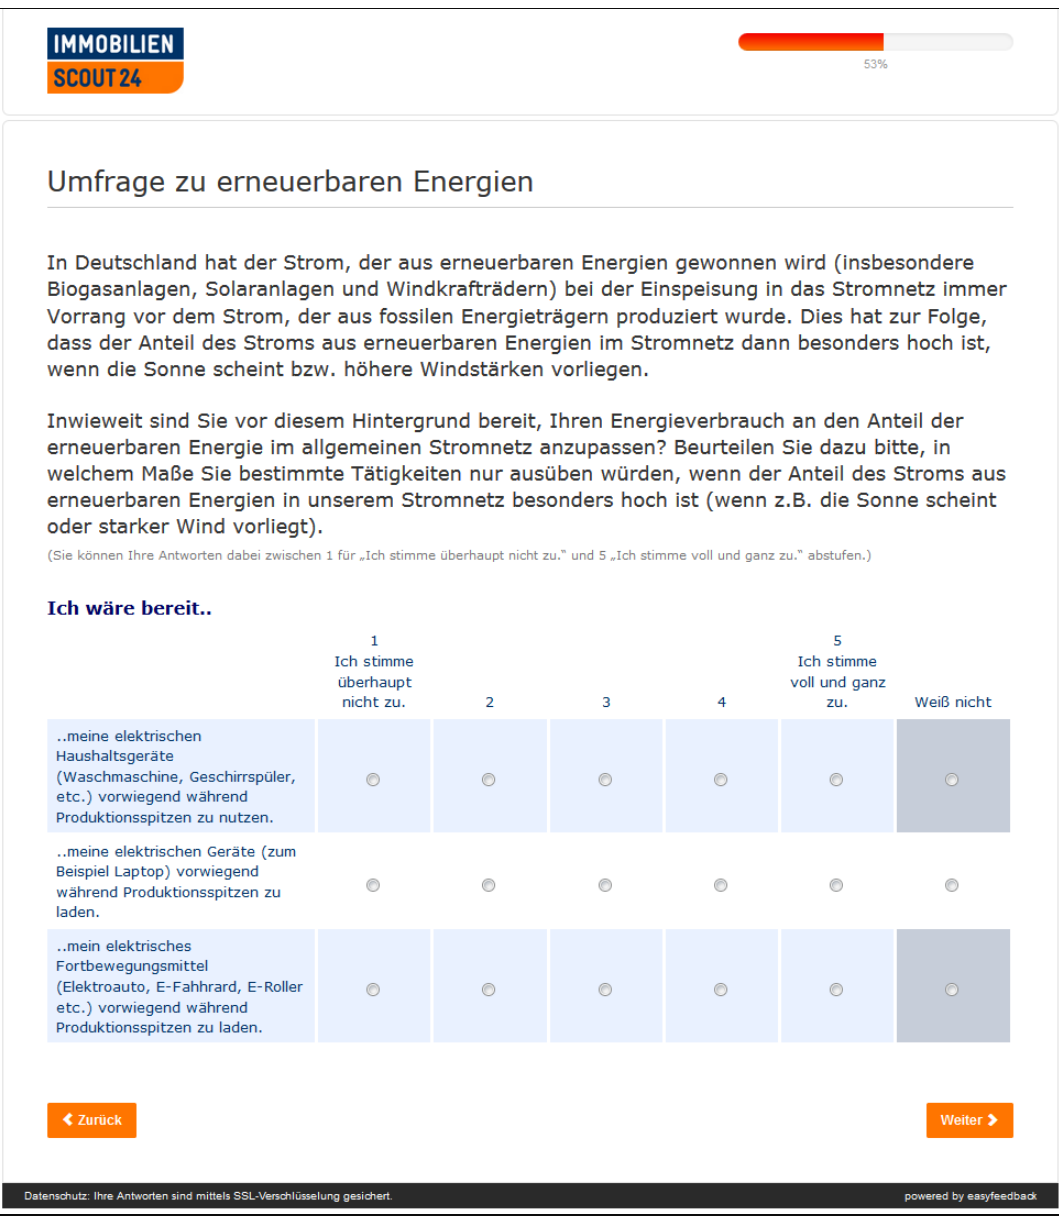
Figure A11. Screenshot of Questionnaire Page 10.